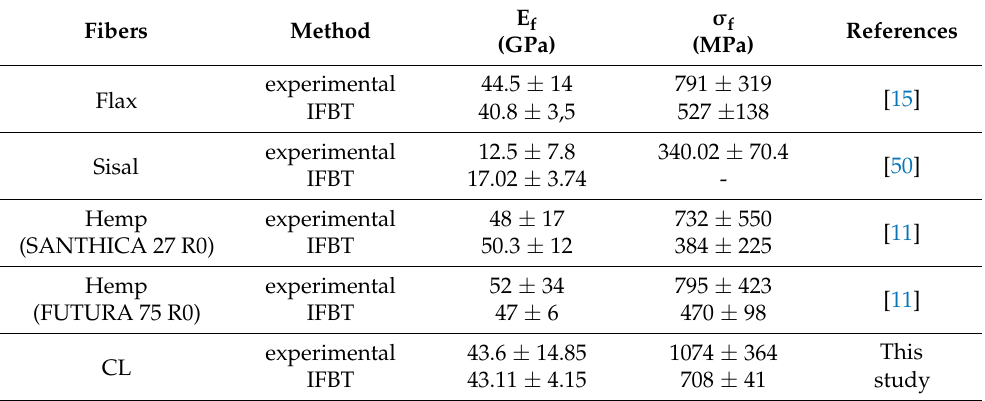
Table 6. Comparison between CL fibers properties with those of plant fibers predicted by IFBT method or identified